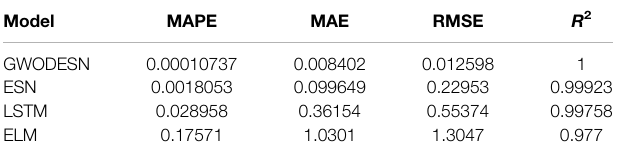
TABLE 1 | The performance comparison of GWODESN, ESN, ELM, and the LSTM for Lorenz x( t ) Model MAPE MAE RMSE R 2 GWODESN